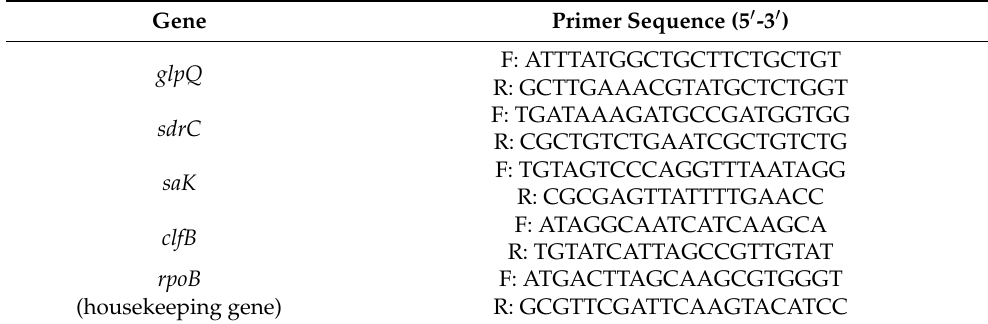
Table 1. List of primers used for RT-qPCR analysis of the selected genes.